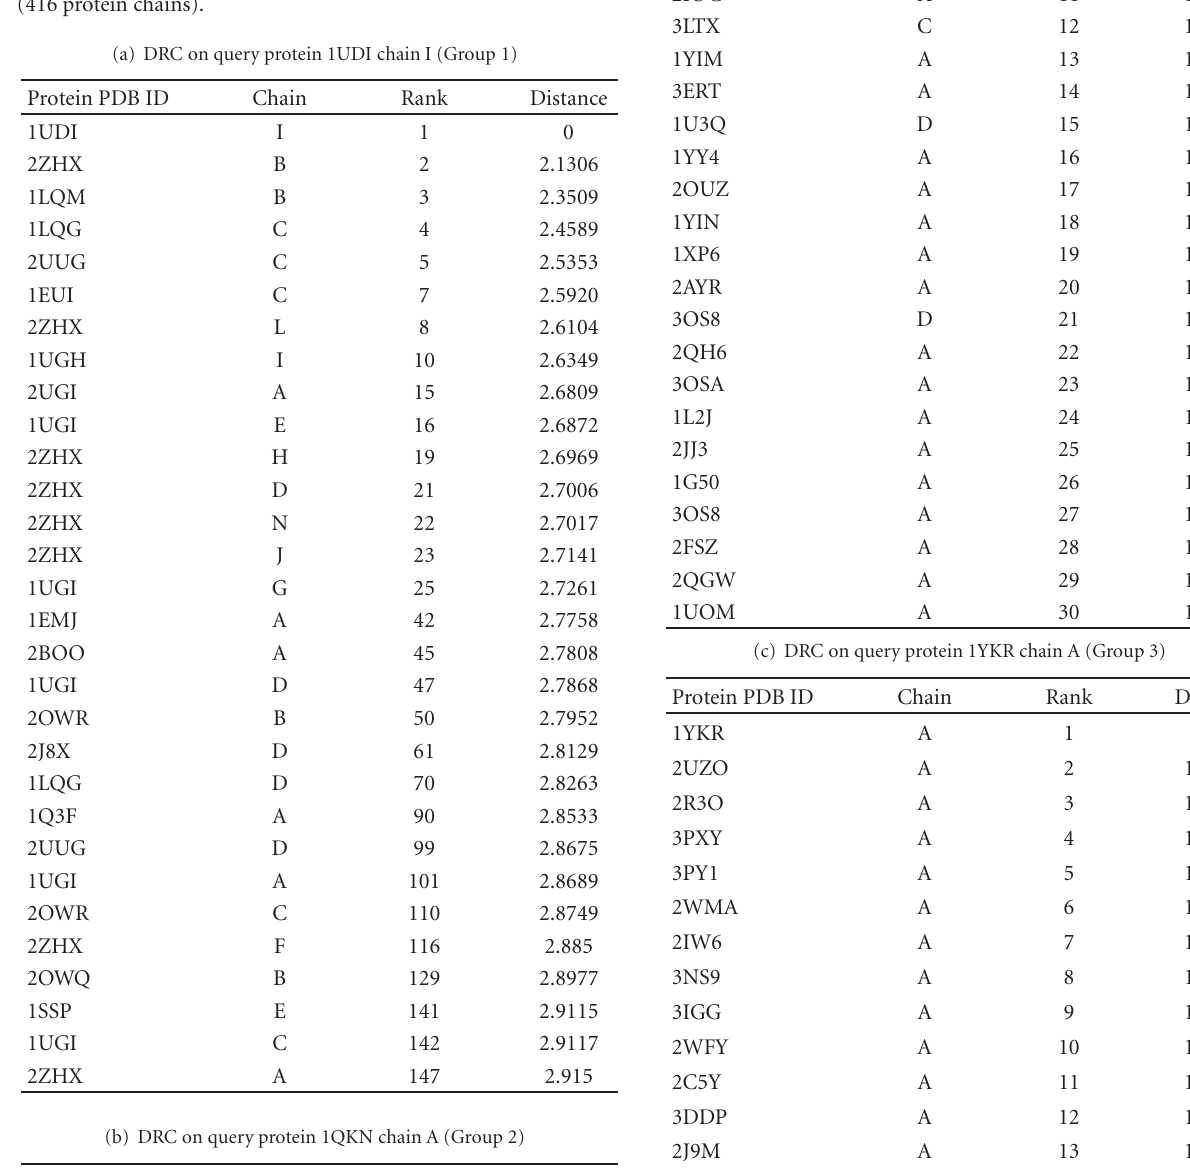
Table 1: Ranking the screened proteins according to their similarity to the query protein. Results are shown for the Top 30 hits for one query protein from each of the three groups, using DATASET-A (416 protein